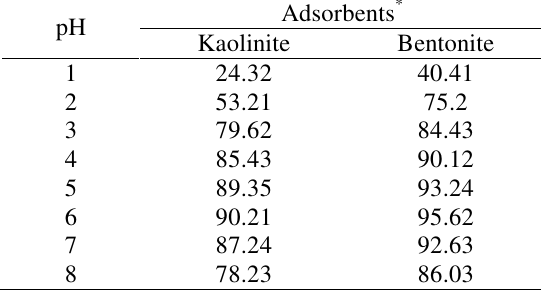
Table 3. Effect of pH on percent removal of nickel(II)